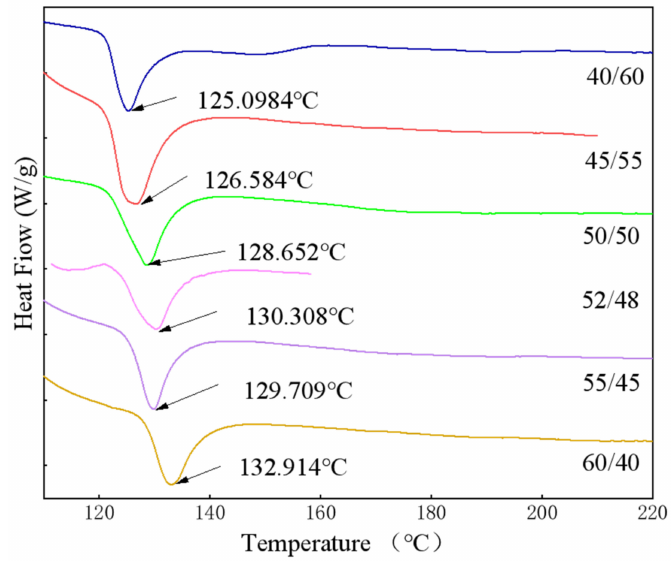
Figure 4. Shows the melting point of In/Sn with ratios of 40/60, 45/55, 50/50, 52/48, 55/45,